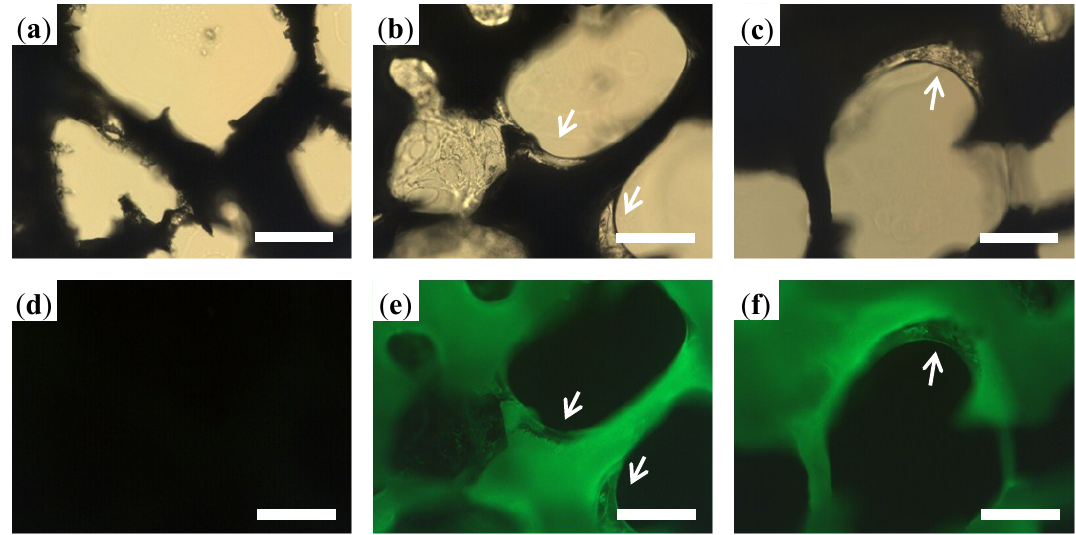
Figure 3. Fluorescence microscopic images of internal structures of porous PLGA scaffold ( a , d ), and PLGA scaffolds with gelatin ( b , e ) and gelatin/rhBMP-2 coating ( c , f ). Scale bar = 100